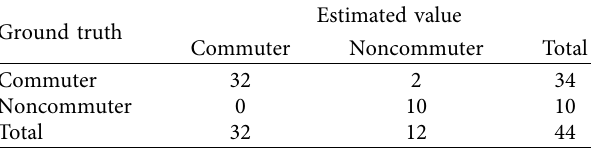
Table 5: Confusion matrix of estimated PT passenger category.